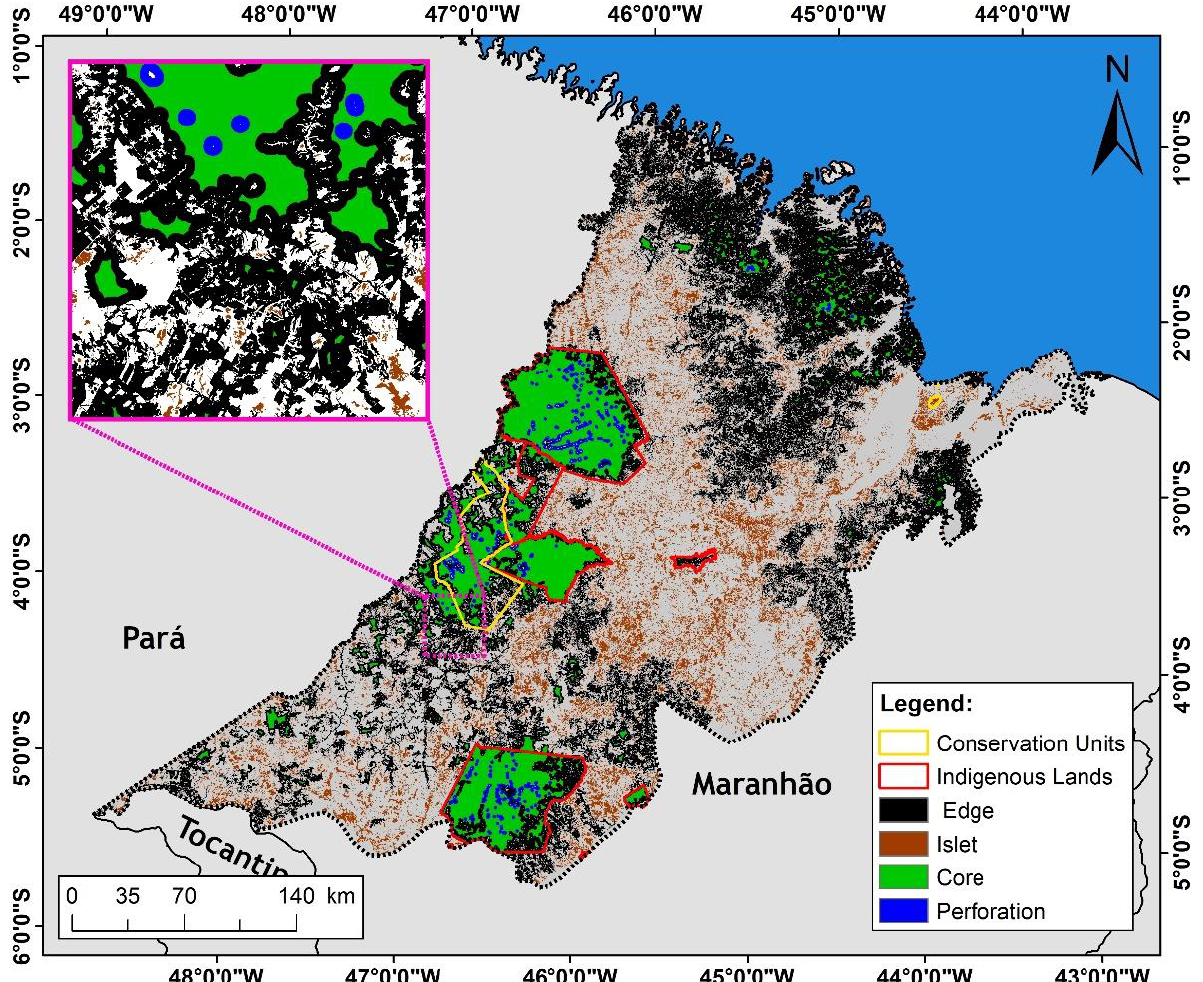
Figure A1. The result of the MSPA (Morphological Spatial Pattern Analysis) algorithm’s classification using the 2017 forest map (see Figure 1).